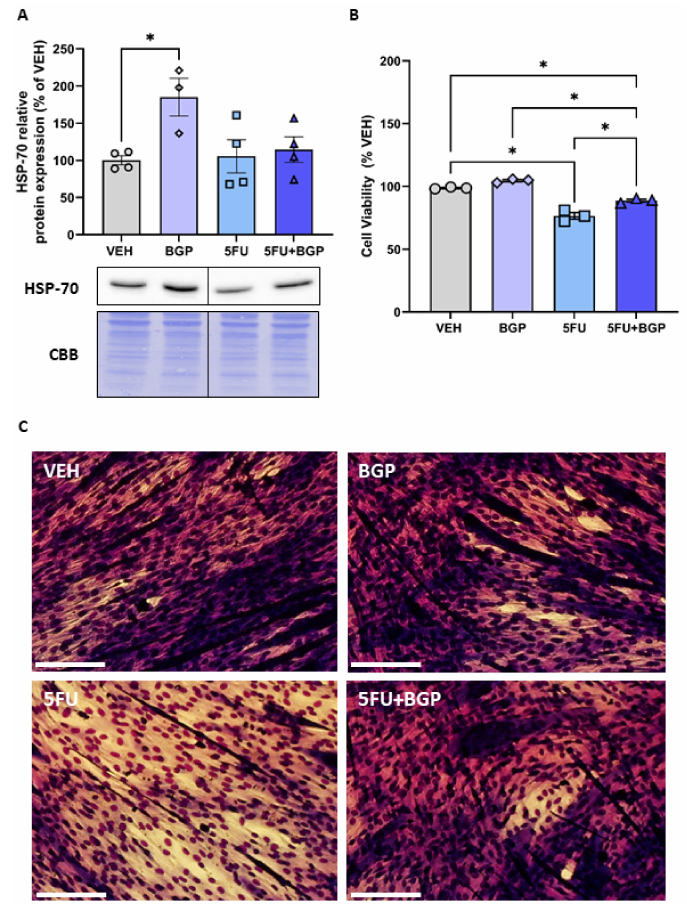
Figure 6. The effect of BGP-15 (BGP), 5-fluorouracil (5FU) and 5FU with BGP (5FU+BGP) treatment on HSP-70 expression and cell viabilityC2C12 myotubes were treated with BGP, 5FU and 5FU with BGP before being prepared as lysates for Western blotting experiments. ( A ) C2C12 lysates were then probed for HSP-70, with protein expression normalised to total protein derived from Coomassie Brilliant Blue (CBB) staining data and data presented as a percentage of the vehicle control group (VEH). ( B ) Cell viability was analyzed via the resazurin cell viability assay, with data presented as a percentage of VEH. ( C ) Representative images for the cell viability assay are displayed. Scale bar = 100 µ m. * = p < 0.05; n = 3–4 for all C2C12 experiments. Data are mean ±